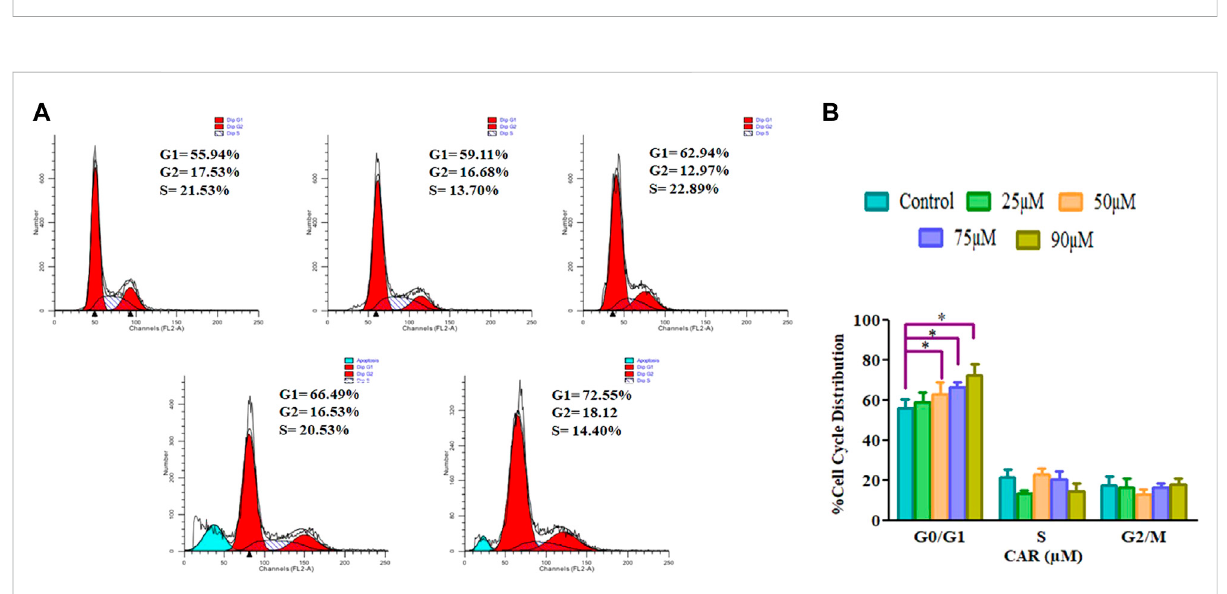
FIGURE 6 CAR-induced cell cycle arrest in cervical cancer cells (A) Cell cycle distribution of propidium iodide-stained C33A cells treated with CAR (25 – 90 μ M) for 24 h observed by fl ow cytometric analysis. Data shown are representative of three independent experiments. (B) Graphical representation of percent cell cycle distribution in C33A cervical carcinoma cells as determined by fl ow cytometric analysis. Data reported are mean±S.E.Mofthreeindividualexperimentsperformedintriplicate.Signi fi cantdifferenceamongthetreatmentgroupswereanalyzedbyone- way ANOVA followed by Dunnett post-hoc test (** p < 0.05 represent signi fi cant difference compared with